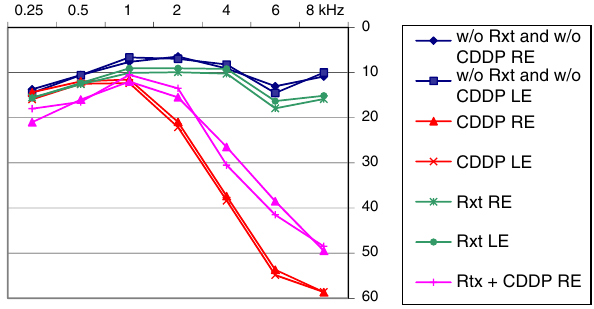
Figure 1 Mean audiometric configuration of hearing thresh- olds by type of treatment. CDDP, cisplatin; Rxt, radiation treatment; RE, right ear; LE, left